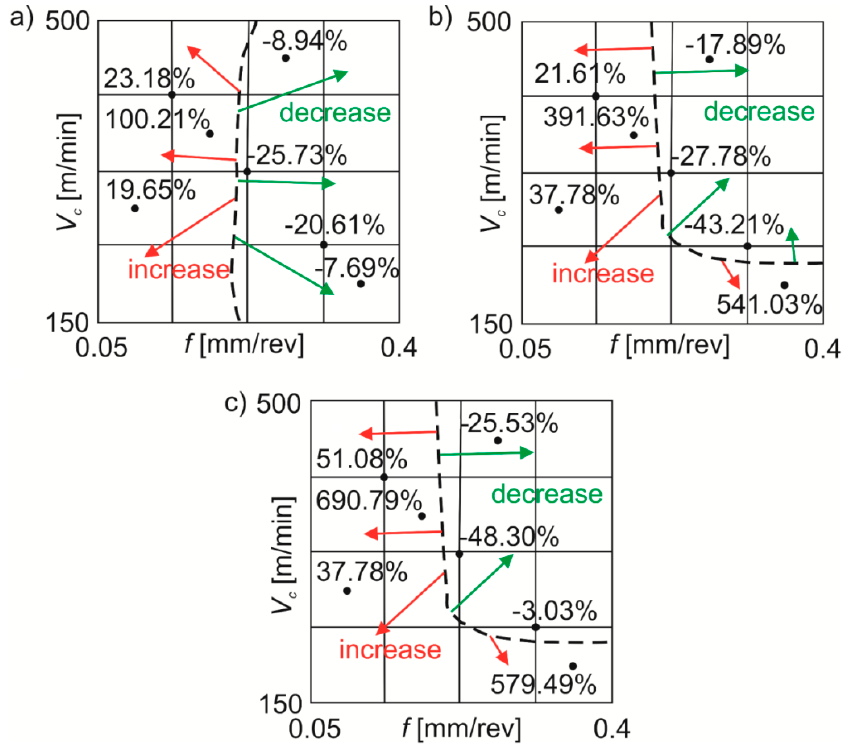
Figure 7. Average percentage changes in the Sa roughness parameter under: ( a ) wet turning; ( b ) MQL; ( c ) MQL + EP conditions in comparison with dry turning.